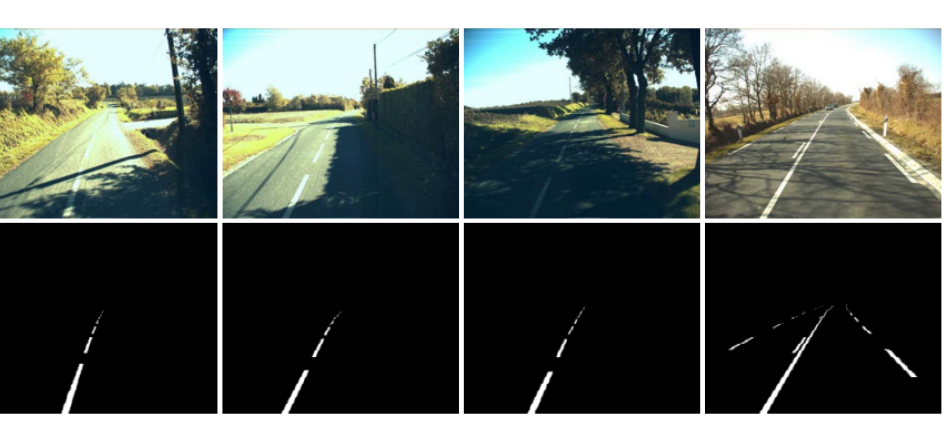
Figure 11. Some examples from the dataset and the corresponding labeled ground truths